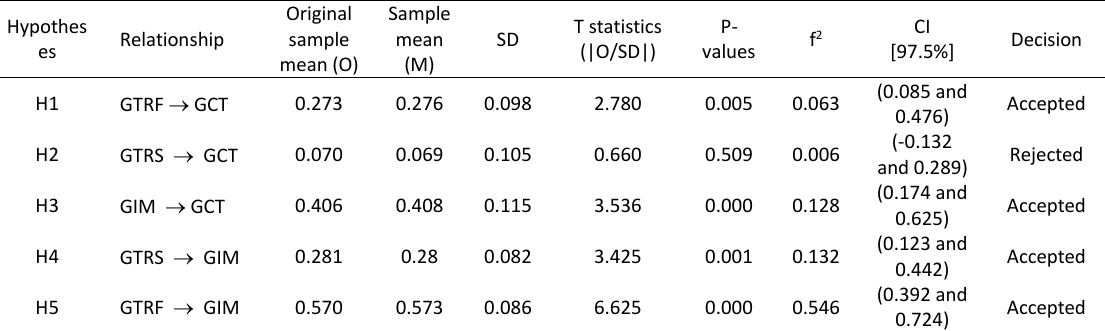
Fig. 1: Direct effect, structural model assessment and factor loading Table 4: Structural model assessment (direct effect result and decision)